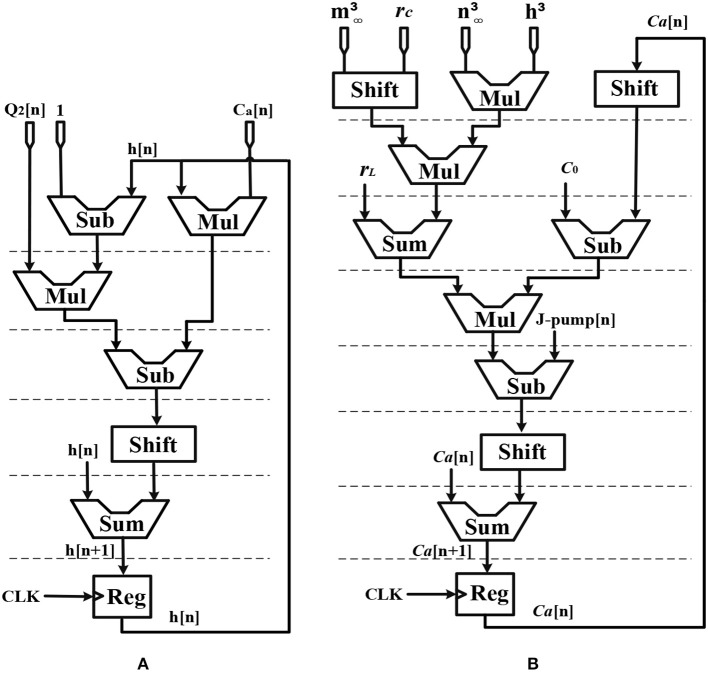
Scheduling diagram for (A)
h[n] and (B)
Ca2+[n].